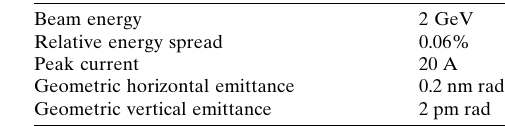
Table 1 Nominal electron beam parameters used in the simulation. Beam energy